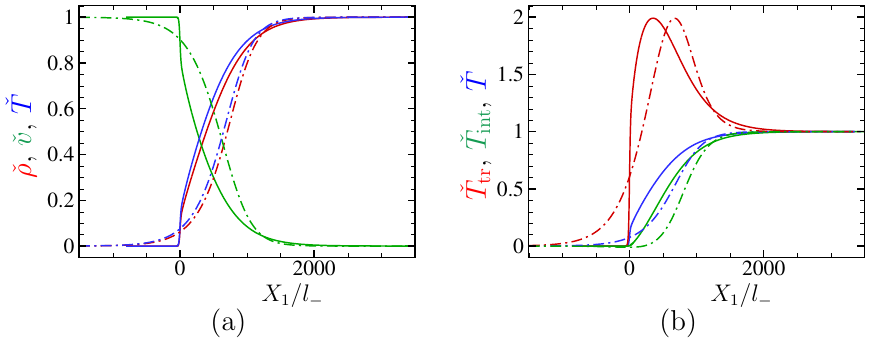
Figure 11. Profiles of ˇ ρ , ˇ v , ˇ T , ˇ T tr , and ˇ T int in the case of SF 6 gas at M − = 1.3. ( a ) ˇ ρ , ˇ v , and ˇ T ; ( b ) ˇ T tr , ˇ T ˇ T . See the caption of Figure 2. int , and